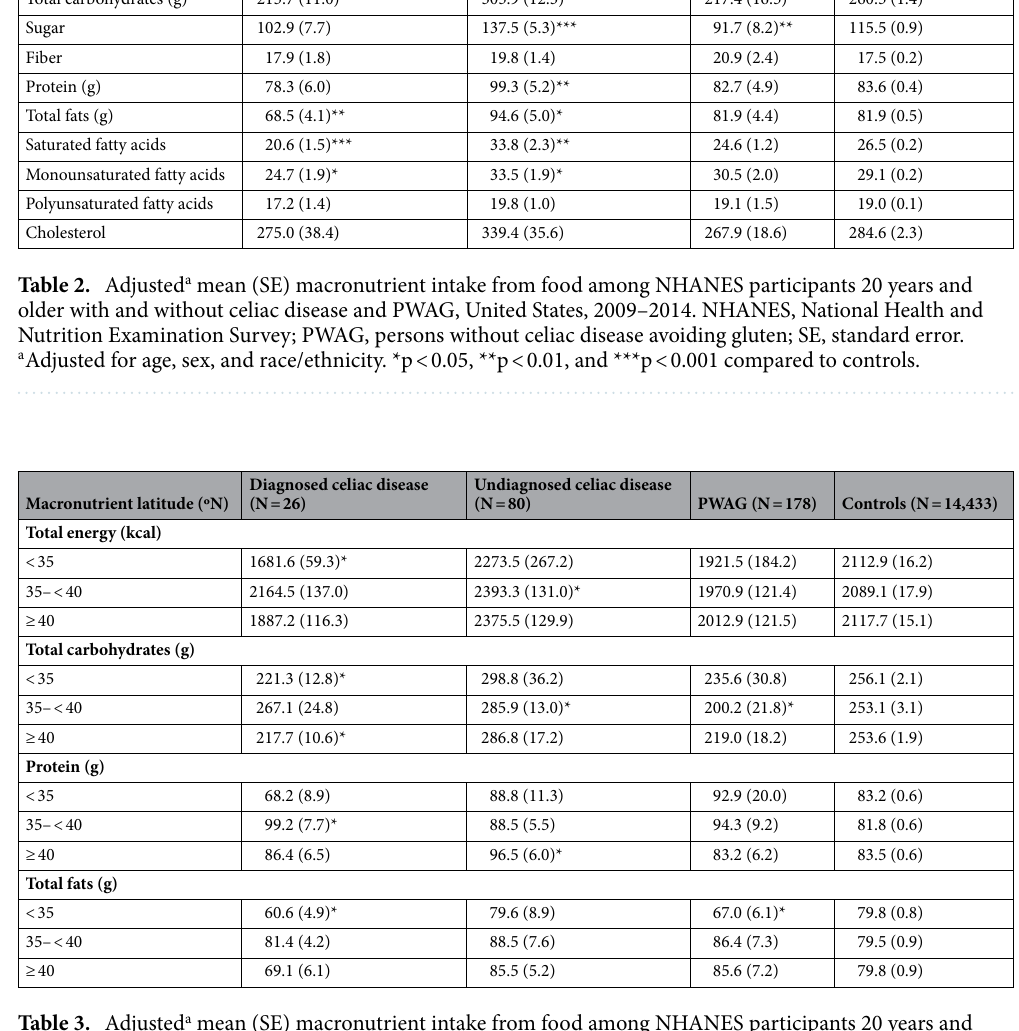
Table 3. Adjusted a mean (SE) macronutrient intake from food among NHANES participants 20 years and older with and without celiac disease and PWAG by latitude, United States, 2009–2014. NHANES, National Health and Nutrition Examination Survey; PWAG, persons without celiac disease avoiding gluten; SE, standard error. a Adjusted for age, sex, and race/ethnicity. * p < 0.05 compared with controls.